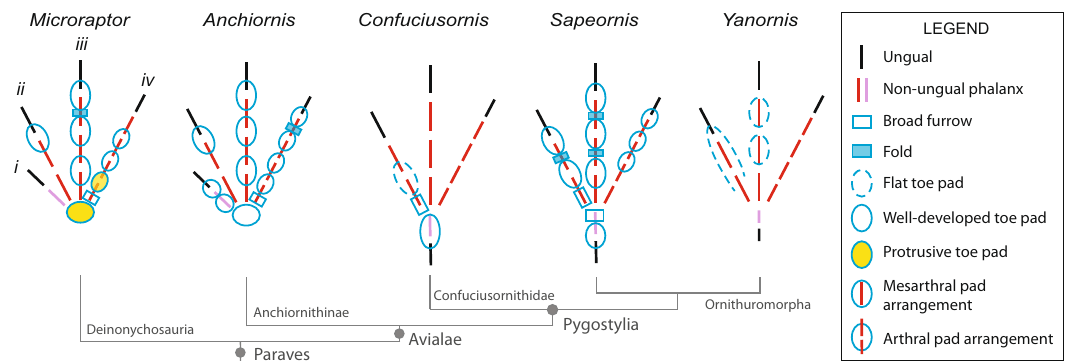
Fig. 1 | Pedal morphology of select early theropod fl yers. Schematic of select early theropod fl yers showing the proportions and arrangement of the toe bonesandthemorphologyandarrangementofthetoepads.Missingpads(i.e., those not preserved) are not indicated. Toe pads in all taxa are arthrally